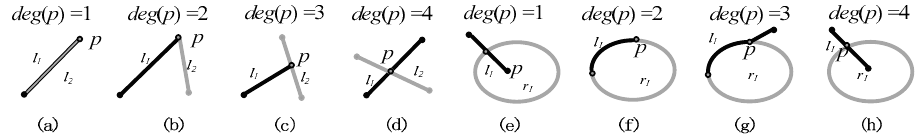
Figure 6. Examples of the degree of a certain point in the union of two spatial objects. ( a ) A point with degree value one in the union of two lines; ( b ) A point with degree value two in the union of two lines; ( c ) A point with degree value three in the union of two lines; ( d ) A point with degree value four in the union of two lines; ( e ) A point with degree value one in the union of a line and the boundary of a region; ( f ) A point with degree value two in the union of a line and the boundary of a region; ( g ) A point with degree value three in the union of a line and the boundary of a region; ( h ) A point with degree value four in the union of a line and the boundary of a region. For the intersection-lines of line/region and line/line, even though the degree of their interior points are all two, there are four different cases of the degree of their end- points, including four possible values, i.e., {1,2,3,4}. In Figure 5a, the degree of p 1 is two and the degree of p 2 is three, while in Figure 5b, the degree of p 1 is one, and the degree of p 2 is four; in Figure 5c, the degrees of p 1 and p 2 are both two, while in Figure 5d, the de- gree of p 1 is one and the degree of p 2 is three. The node degree, i.e., “degree of point”, can be used to distinguish different types of intersection-lines in Figure 5. It is clear that the node degree is a topological invariant, and its ability to distinguish intersecting lines is better than that of the Euler number. In addition, because the degree of the intersection-point can also work well in the discrimination of intersection-points, the node degree is used to distinguish both types of intersection-points and intersec- tion-lines between lines/regions and lines/lines. Therefore, a N-WWIS model can be proposed for representing the refined line/region and line/line relations. 3. Classification of Intersection-Lines and Intersection-Points Based on Node Degrees 3.1. Classification of the Intersection-Line between the Line and Region As mentioned above, the intersection-line of the line/region can be distinguished using the degrees of the two endpoints of the intersection-line (i.e., p 1 and p 2 in Figure 7). Since there are four possible values for the degree of each endpoint, there are theoreti- cally 16 (4 × 4) possible combinations. Excluding the impossible and symmetric values, we can obtain 8 types of possible intersection component types (i.e., the types actually exist in R 2 ), whose node degrees are (1, 1), (1, 3), (1, 4), (2, 2), (2, 3), (3, 3), (3, 4), and (4, 4), as shown in Figure 7. Figure 7. Intersection-line types of line/region that can be distinguished by node degree. ( a ) Case of degree-pair (1,1); ( b ) Case of degree-pair (1,3); ( c ) Case of degree-pair (1,4); ( d ) Case of degree-pair (2,2); ( e ) Case of degree-pair (2,3); ( f ) Case of degree-pair (3,3); ( g ) Case of degree-pair (3,4); ( h ) Case of degree-pair (4,4). This method can fully distinguish the types of intersection-lines whose degree val- ues of endpoints are all one or two. However, other types of intersection-lines cannot be